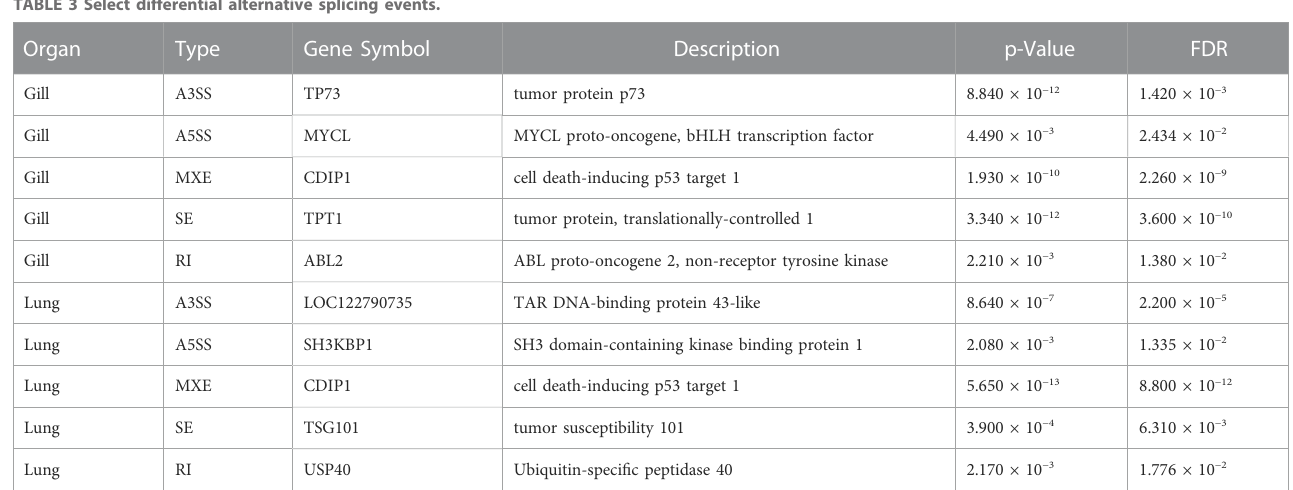
TABLE 3 Select differential alternative splicing